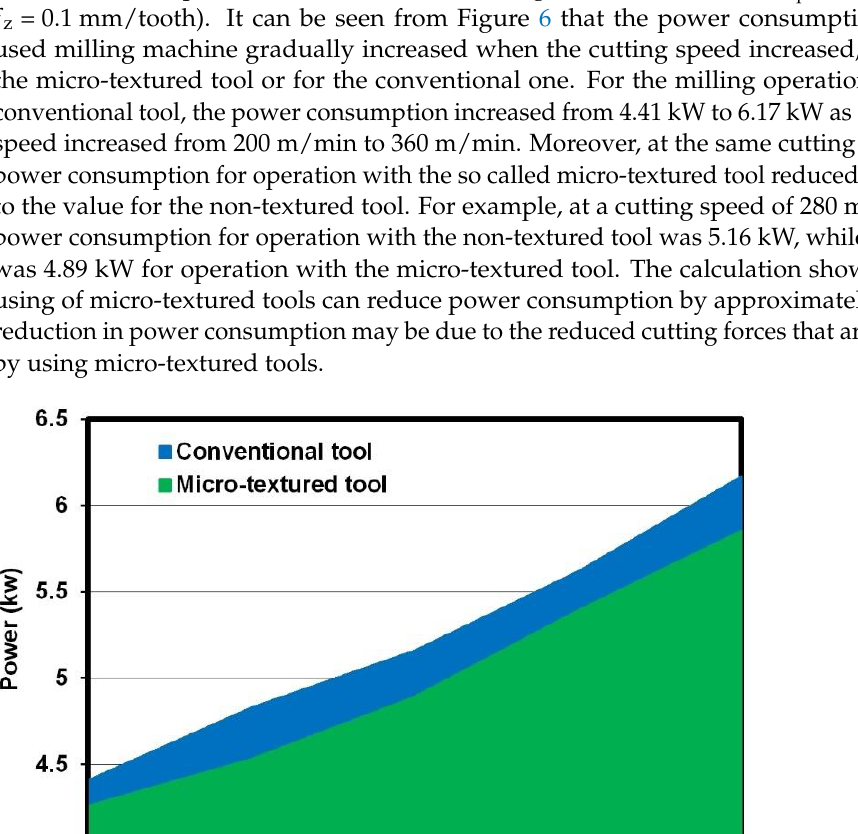
Figure 5. Tool lives obtained under different cutting conditions.